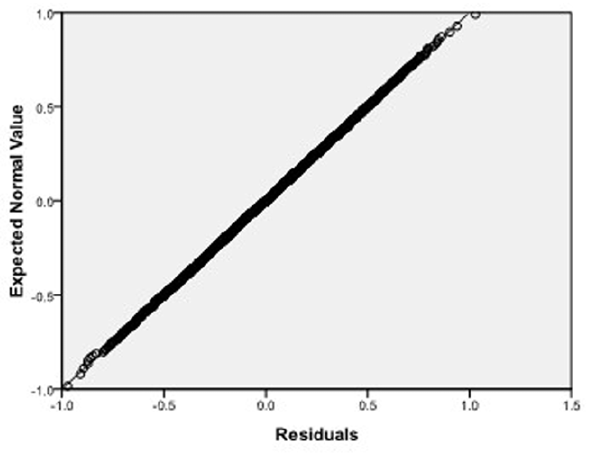
Figure 20. Histogram and asymptotic distribution for ^ bb 1 of GLS when the variance function of the error term is Figure 22. Normal Q-Q plot of residuals of ^ bb